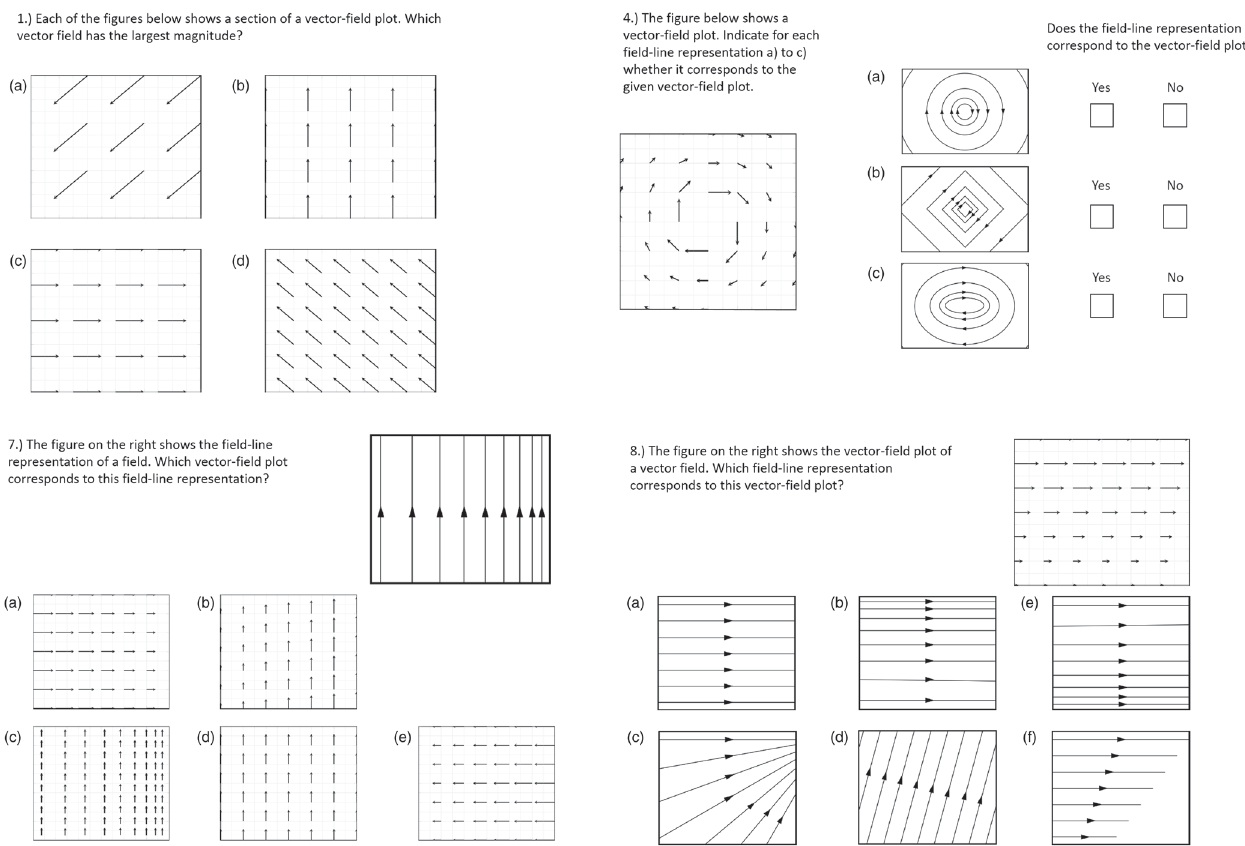
FIG. 3. Items 1, 4, 7, and 8 of the